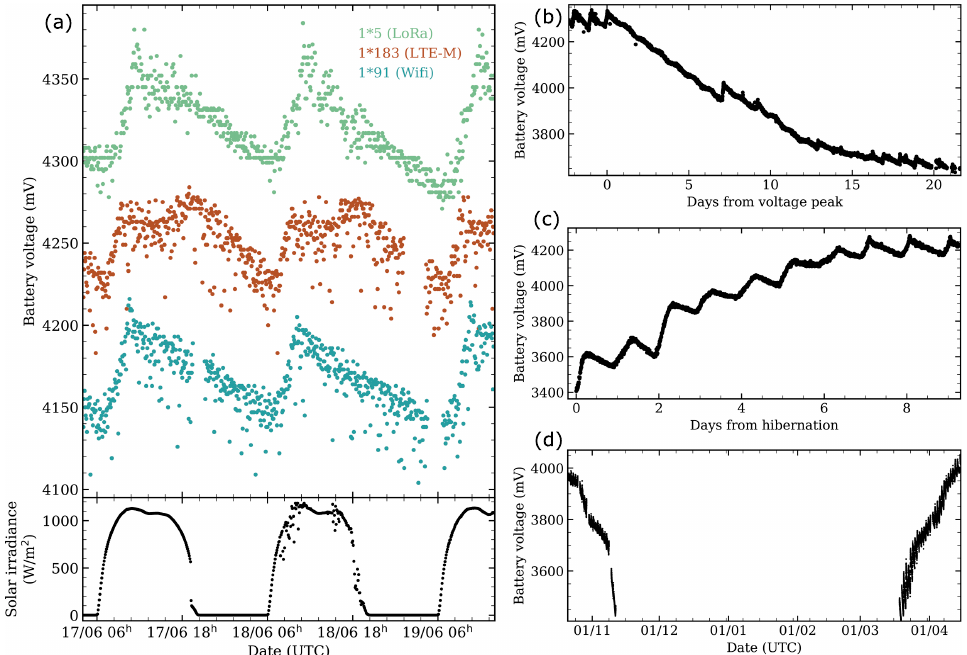
Figure 3. ( a ) Normal charge –discharge cycle for three photometers SG-WAS LoRa (green), LTE-M (brown), and WiFi (blue) versions located at the Teide Observatory (OT, Canary Islands, Spain). The solar irradiance, measured by the Stella telescopes weather station, is shown at the bottom; ( b ) discharge curve of an SG-WAS WiFi when not exposed to direct sunlight. It takes more than 20 days to stop taking measurements uninterruptedly until it reaches the hibernation state; ( c ) charge curve of an SG-WAS once it receives direct sunlight from the hibernation state; ( d ) voltage curve of the device 1 ∗ 53 placed in the Valley of Tejeda (Gran Canaria, Spain), which is no longer exposed to direct sunlight in mid-November, remains in hibernation for 4 months and is charged in March when it begins to receive sunlight